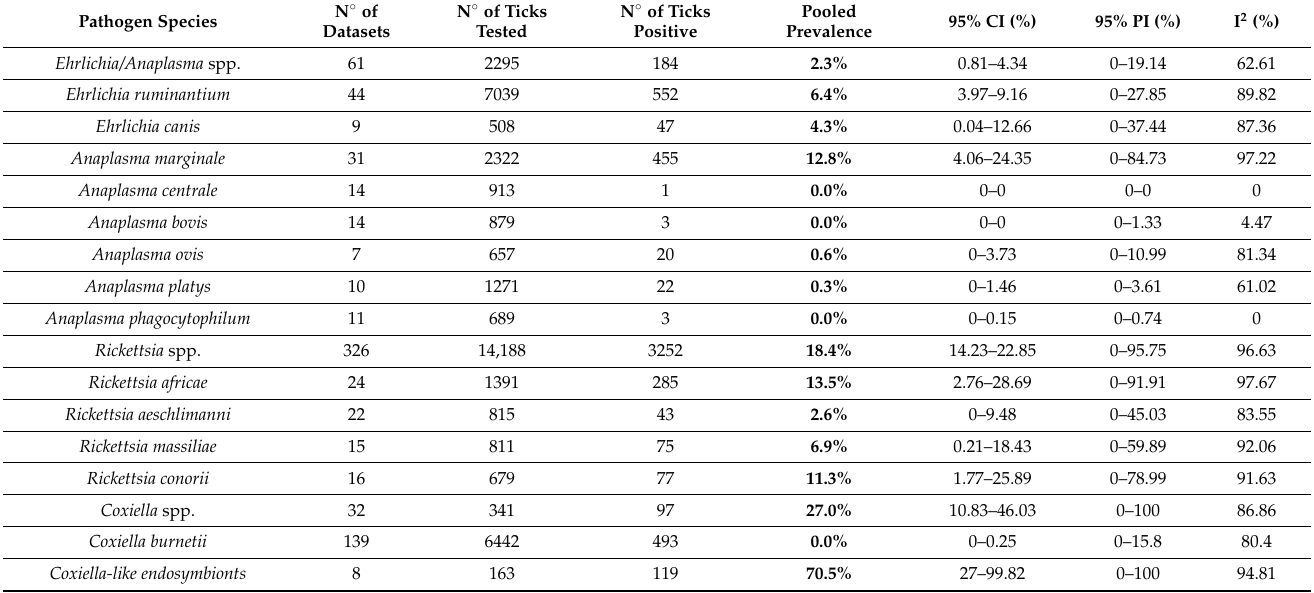
Table 2. Meta-analysis on the molecular prevalence of Anaplasmataceae , Rickettsiaceae and Coxiellaceae in African ticks.